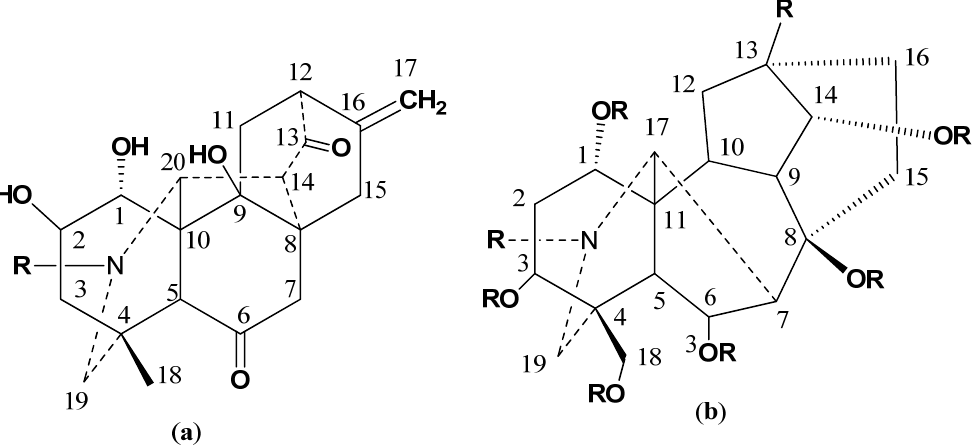
Figure 1. General structures of ( a ) C-20 diterpenoid alkaloids ( b ) C-19 diterpenoid alkaloids. Alzheimer’s disease (AD) is considered to be one of the most closely related forms of